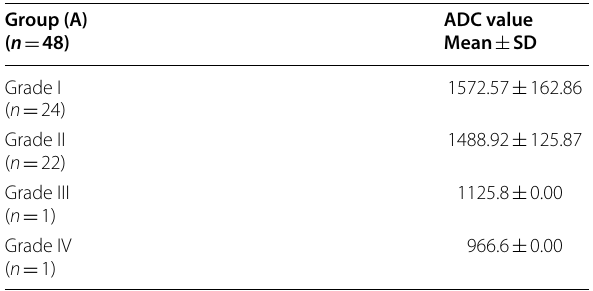
Table 7 ADC value of ONH among group (A) patients